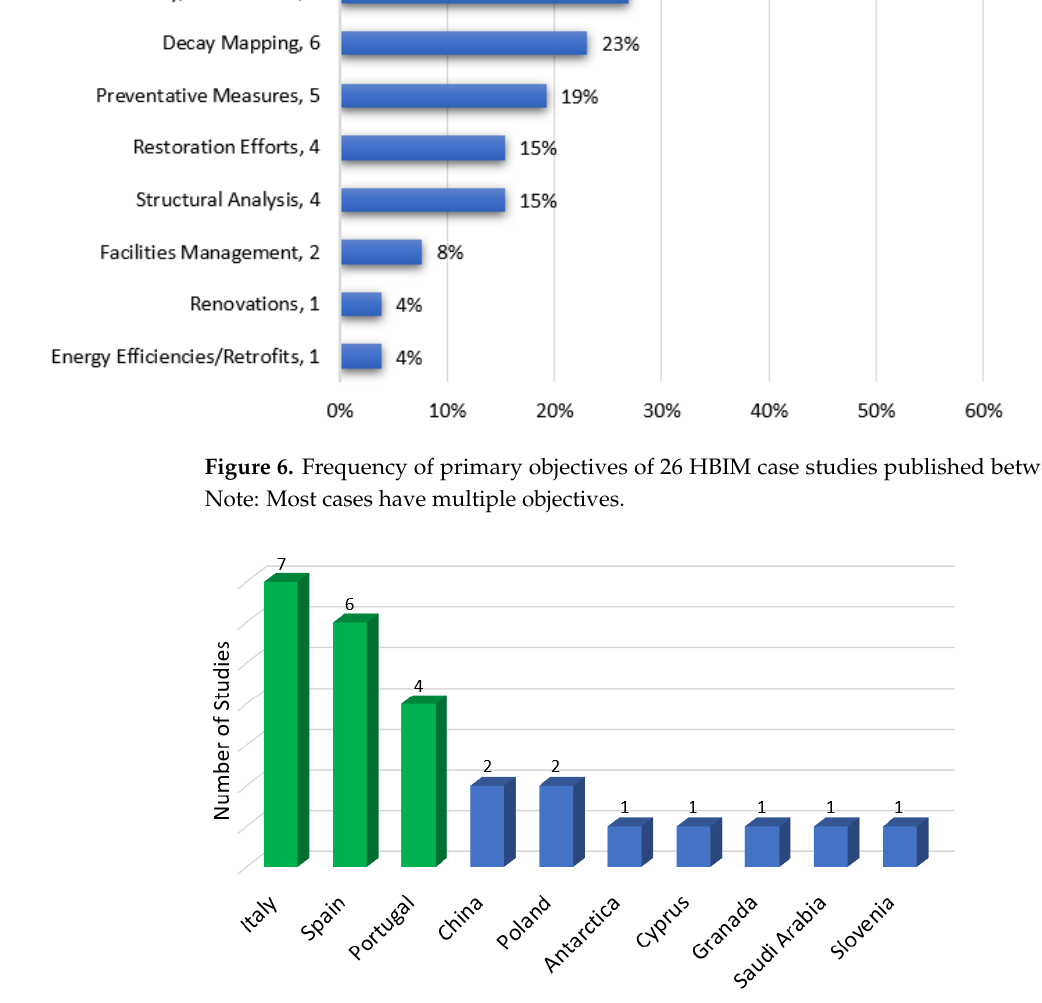
Figure 6. Frequency of primary objectives of 26 HBIM case studies published between 2018–2022. Note: Most cases have multiple objectives.